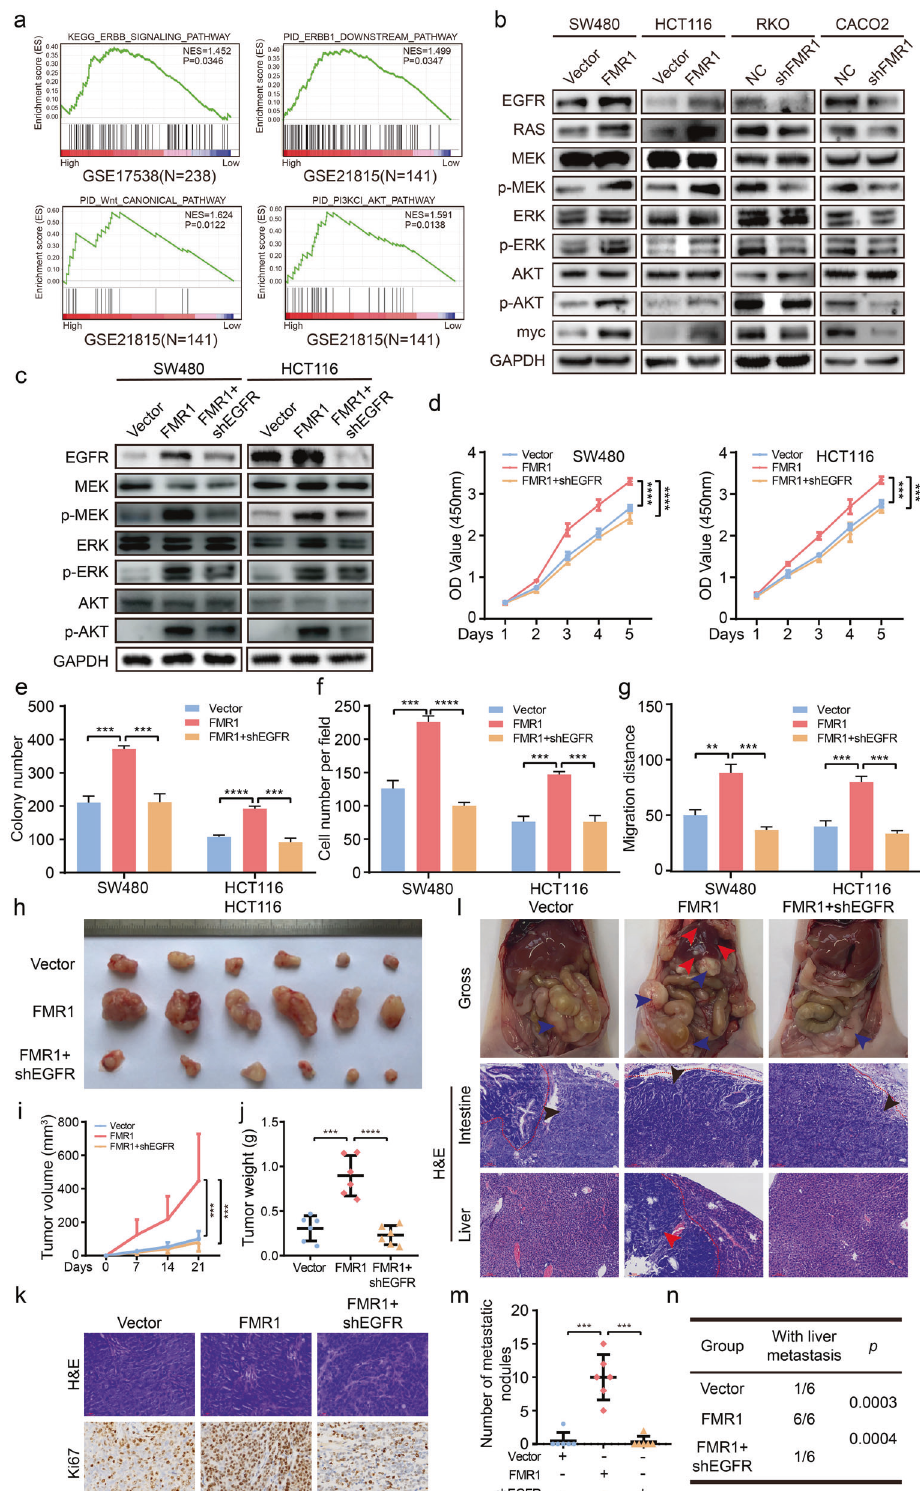
weight and percentage of Ki67-positive cells in subcutaneous tumors of FMR1 overexpression was higher (Fig. 2k – m). Collec- tively, these results demonstrate that FMR1 could promote CRC cell proliferation by prohibiting apoptosis and promoting cell cycle